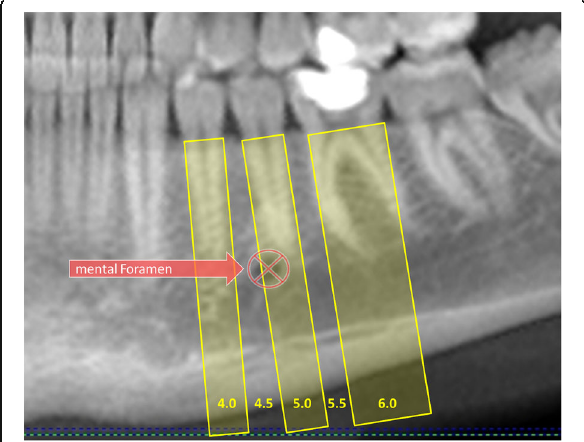
Fig. 2 Definition of the position of the mental foramen